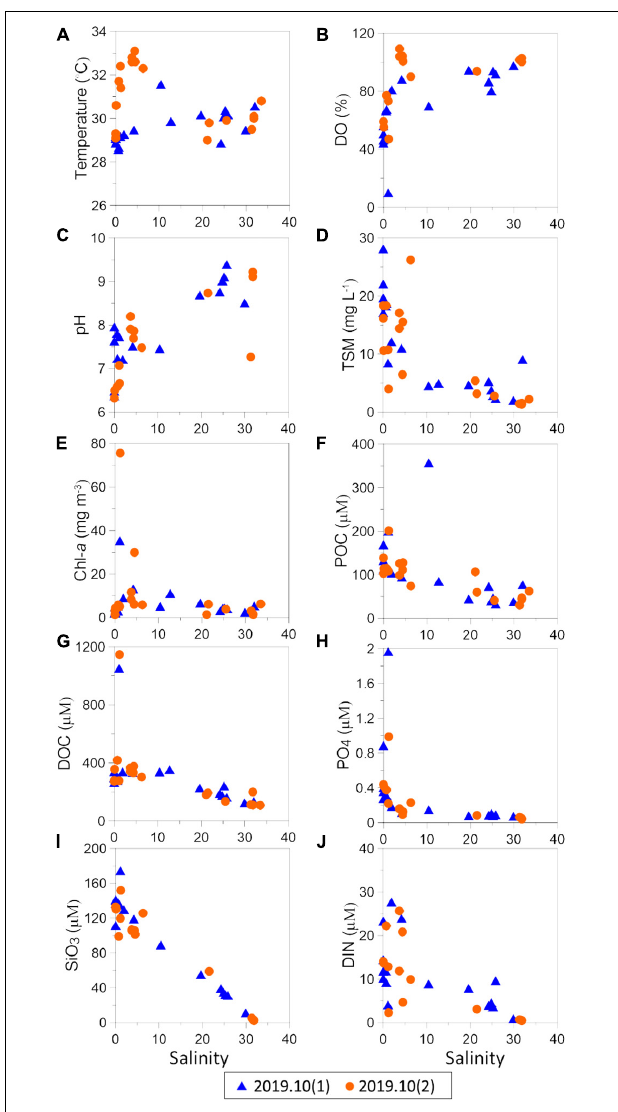
FIGURE 7 | The distribution of (A) surface temperature, (B) DO, (C) pH, (D) TSM, (E) Chl- a , (F) POC, (G) DOC, (H) PO4, (I) SiO3, and (J) DIN along the salinity gradient in wet